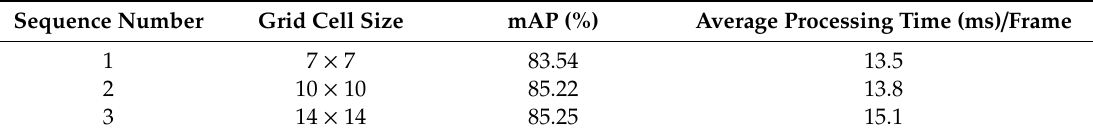
Table 2. The pedestrian detection performance of YOLOv3 under di ff erent grid cell sizes.